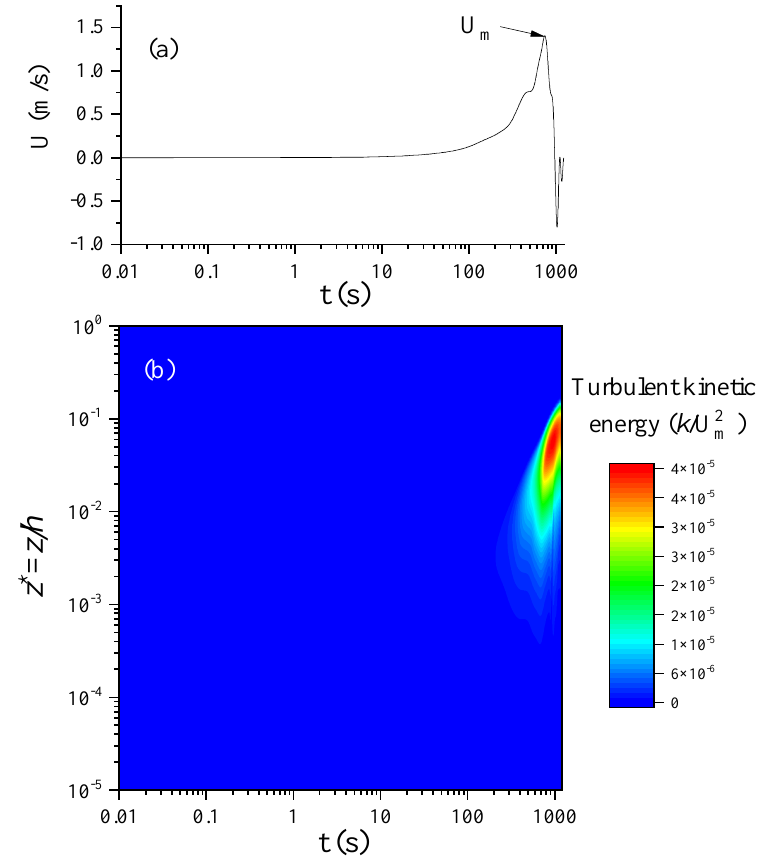
Figure 5. ( a ) Time variation in free stream velocity, ( b ) distribution of turbulent kinetic energy.